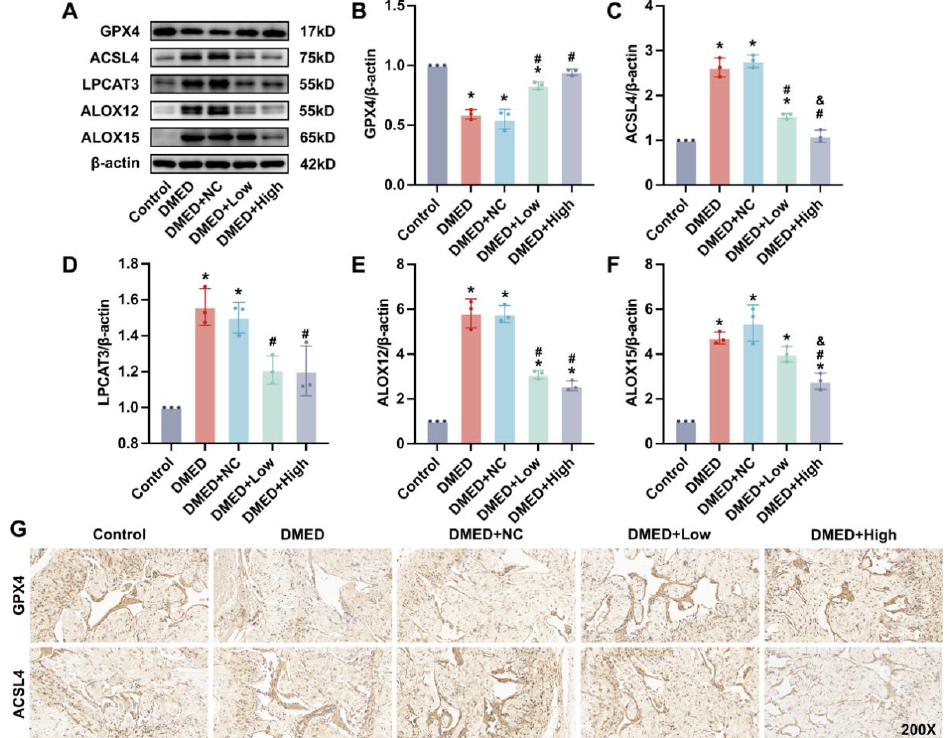
Figure 2. Effect of GPX4-LV injection on ferroptosis in diabetes mellitus-induced erectile dysfunc- tion (DMED) rats. Representative immunoblot ( A ) and semi-quantification ( B – F ) of GPX4,